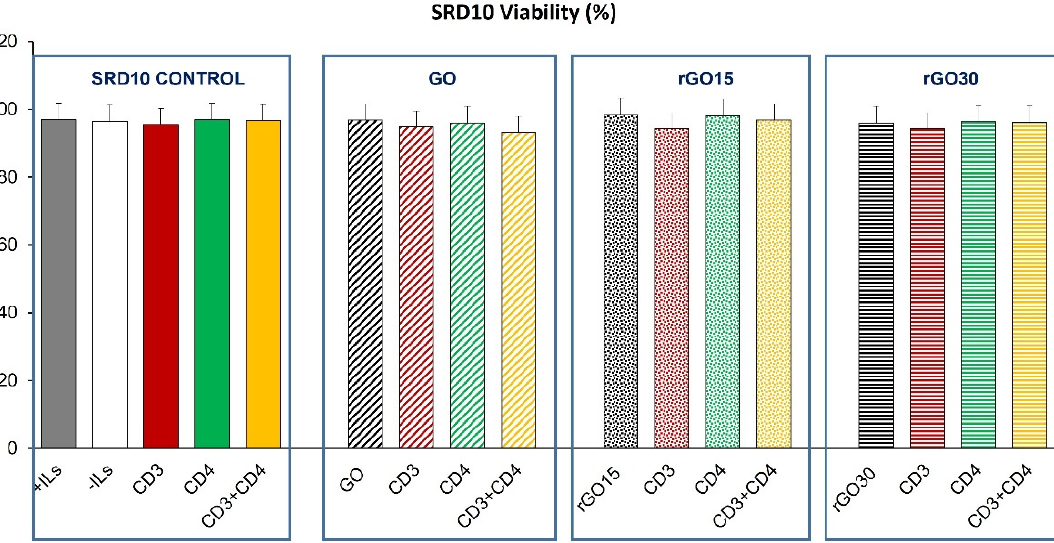
Figure 6. Effect of GO, rGO15 and rGO30 on the viability of CD4+ Th2 SR.D10 cell line after 24 h of treatment with 5 µg/mL of these nanostructures, evaluated by flow cytometry under basal and stimulated conditions. The control cells were cultured in the presence of stimuli without material (SR.D10 CONTROL) in parallel.